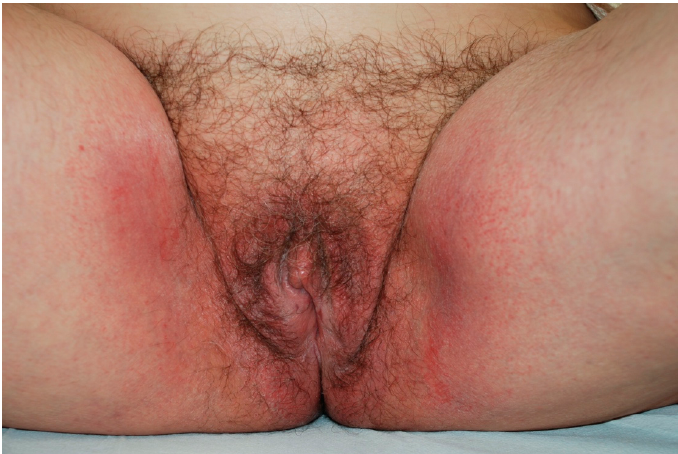
Figure 4. Allergic contact dermatitis due to fragrances contained in a soothing cream. Table 3. List of the most common fragrances and medicaments responsible for vulvar ACD.